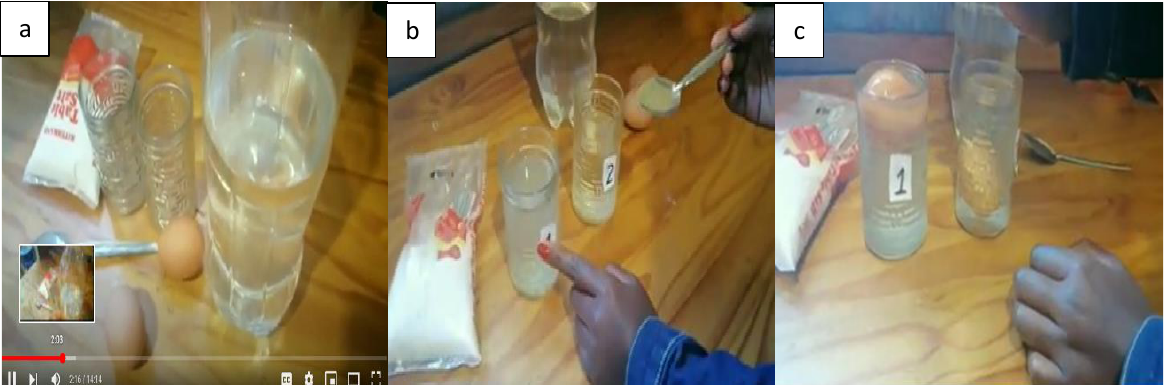
Figure 3. Group 3 experiment: comparing the densities of salty and fresh water